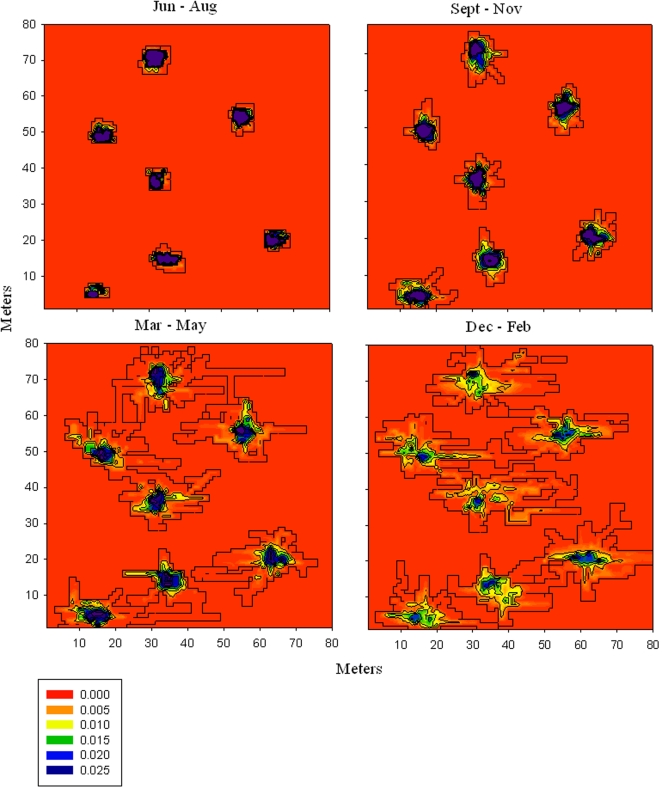
Seasonal home ranges of N. coriiceps.
The precise locations of free-ranging fish were determined continually by acoustic telemetry throughout the year (n = 7). The 3-D spatial distribution plot was created by assigning positional data within 1 m2 cells over the range of the fish. The number of fixes per cell was calculated as a probability distribution of the total positional fixes for each 3 month period. The probability scale interval is 0.005, and purple areas indicate cells where the probability distribution was >0.03, the black outline indicates the outer boundary of the home range.